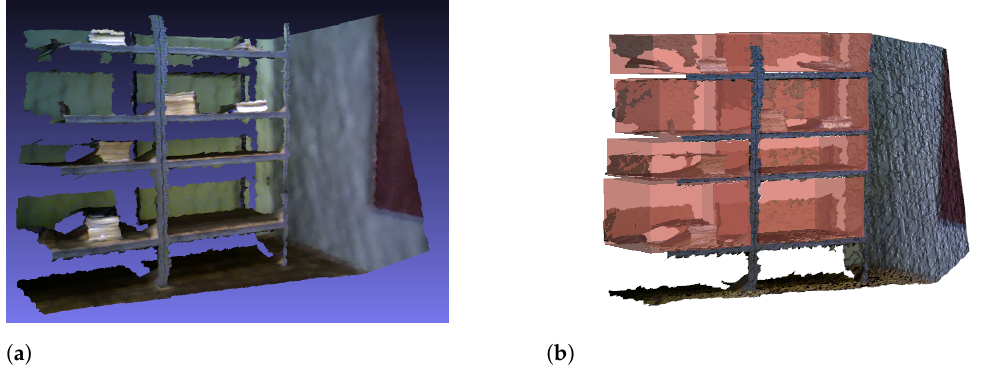
Figure 11. Ground truth annotation of the household furniture. ( a ) A bookshelf captured by an RGB-D camera. ( b ) A bookshelf with ground truth annotation.